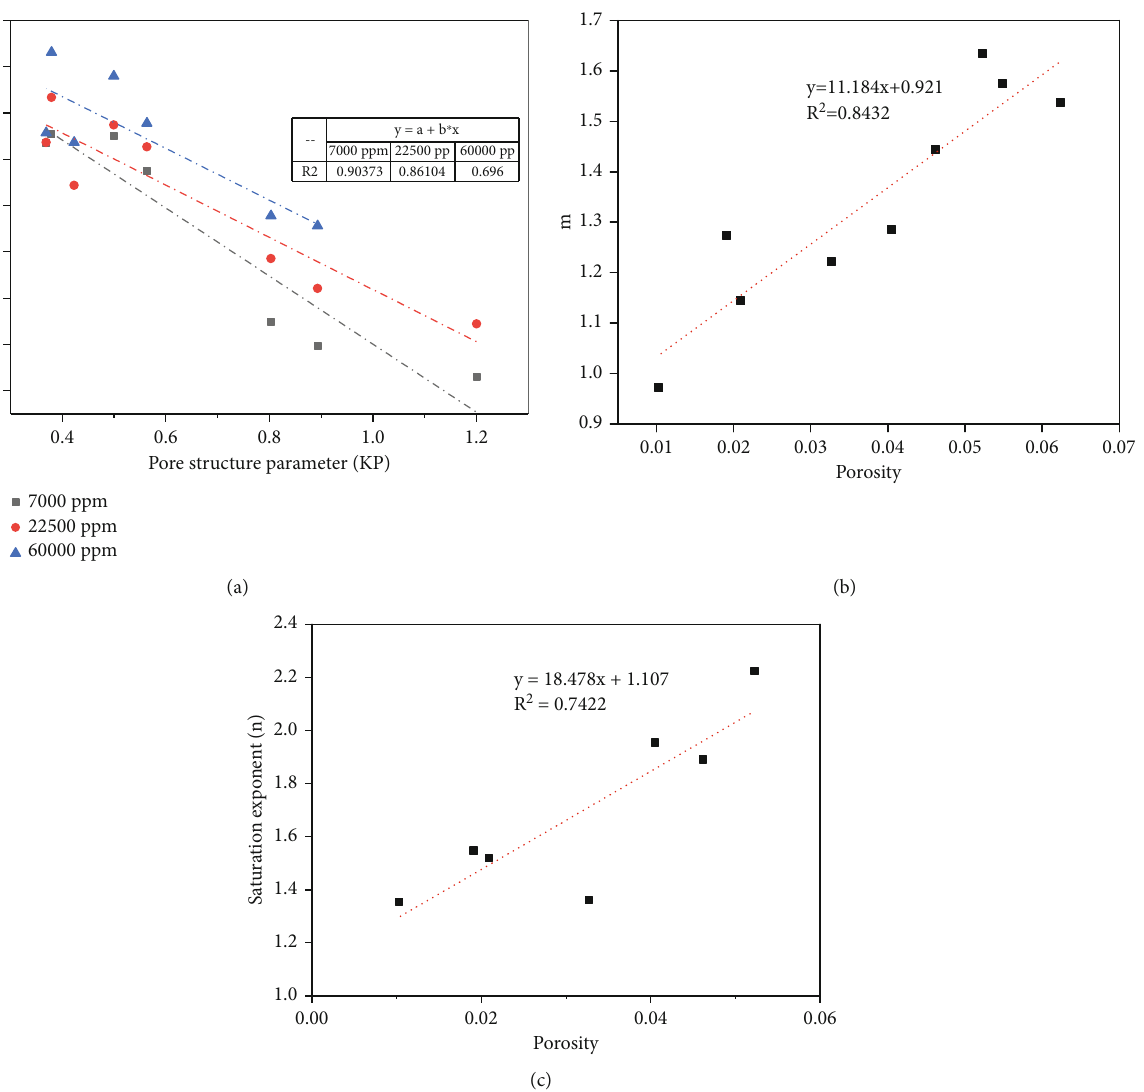
Figure 11: The correlation between Archie ’ s parameters and pore system. (a) Pore structure parameter vs cementation factor; (b) porosity vs. cementation factor; (c) saturation exponent vs.